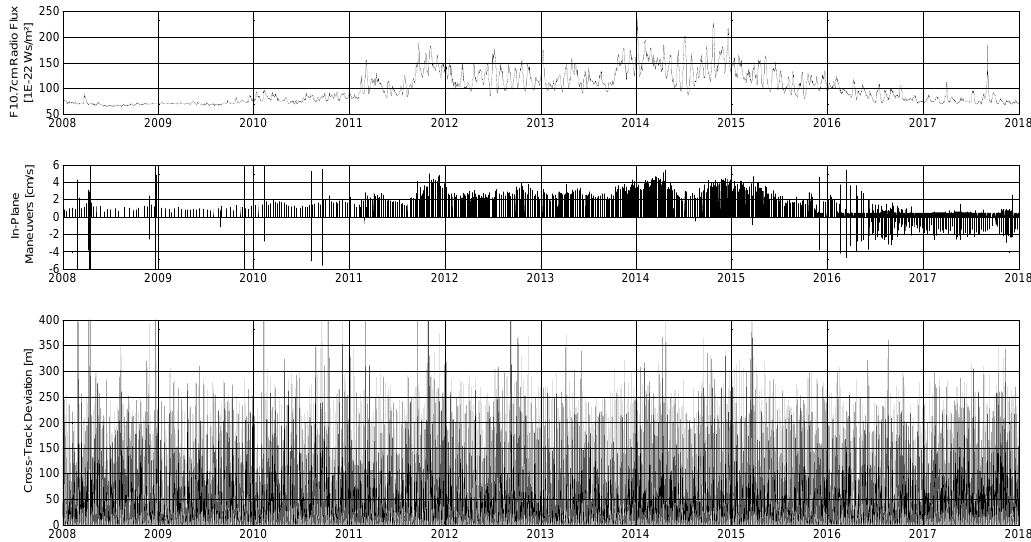
Figure 14. F10.7 cm solar flux ( top ), TSX in-plane maneuver activity ( middle ), and achieved cross-track deviation from the reference orbit ( bottom ) in period 2008–2017.